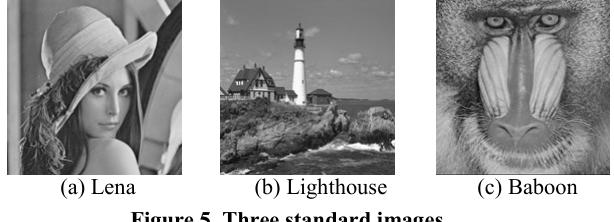
Figure 5. Three standard images